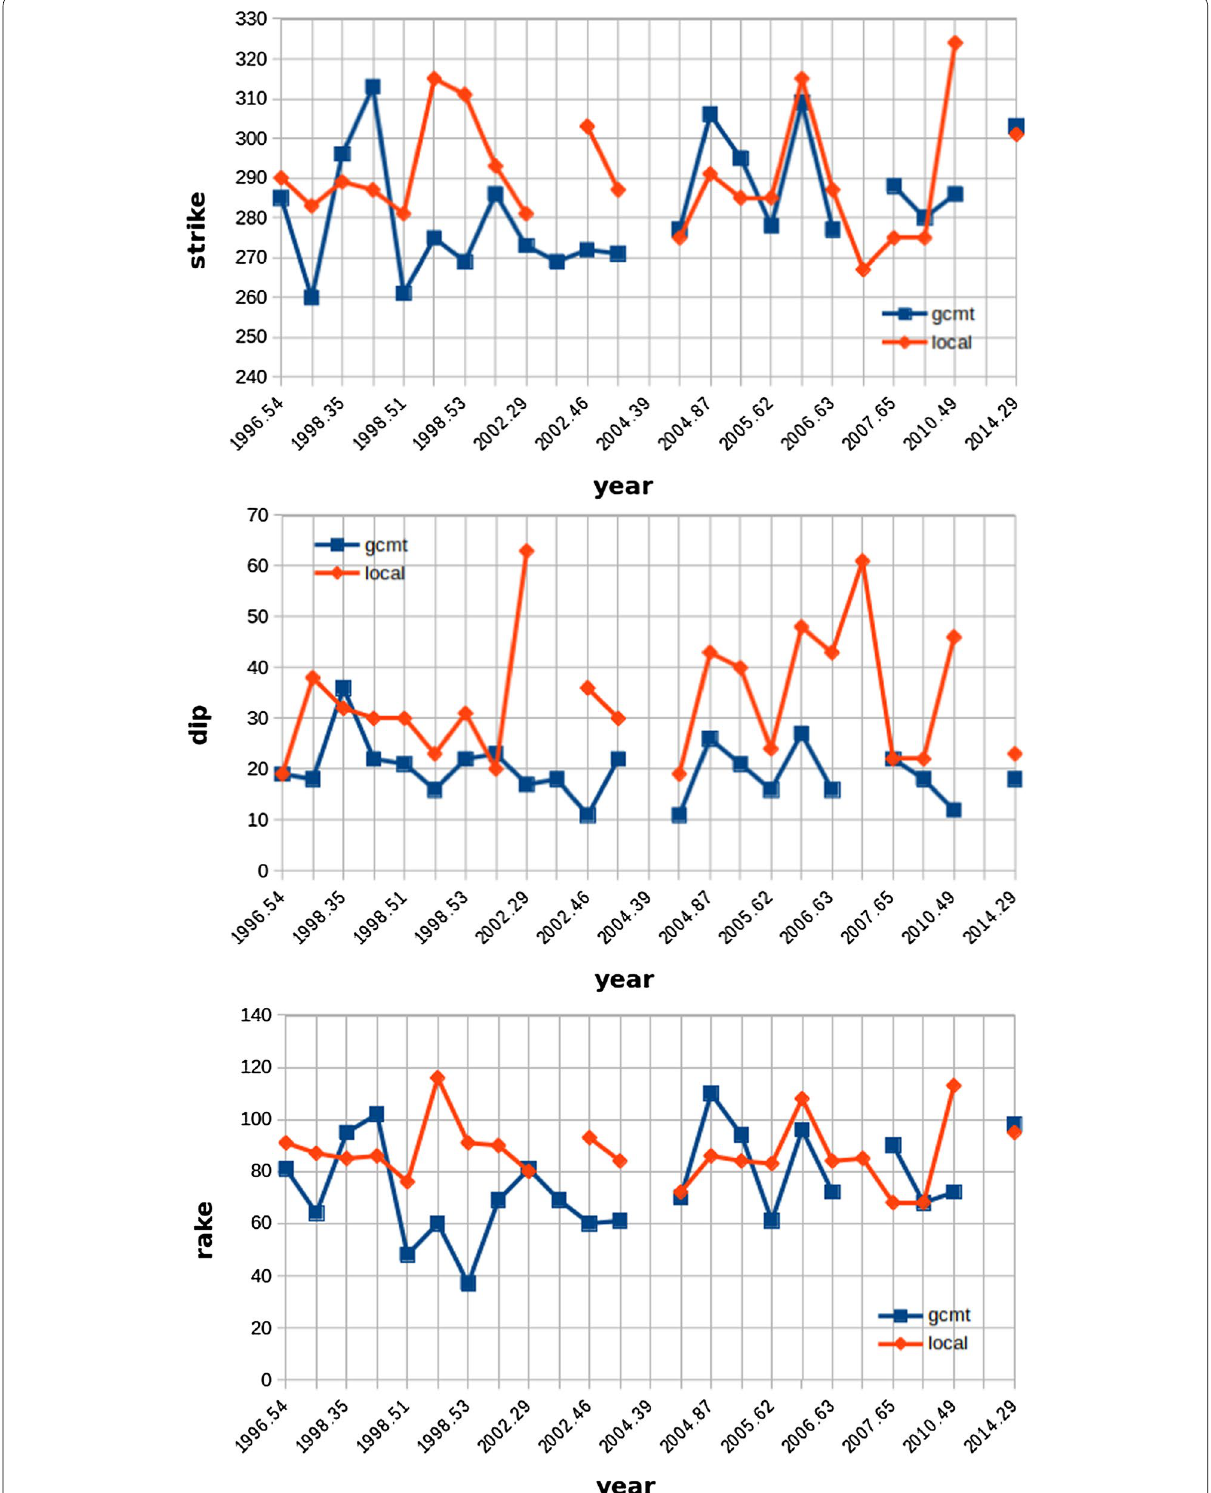
Fig. 8 Comparison of earthquake focal mechanism parameters (strike, dip, rake) for local data and Global CMT